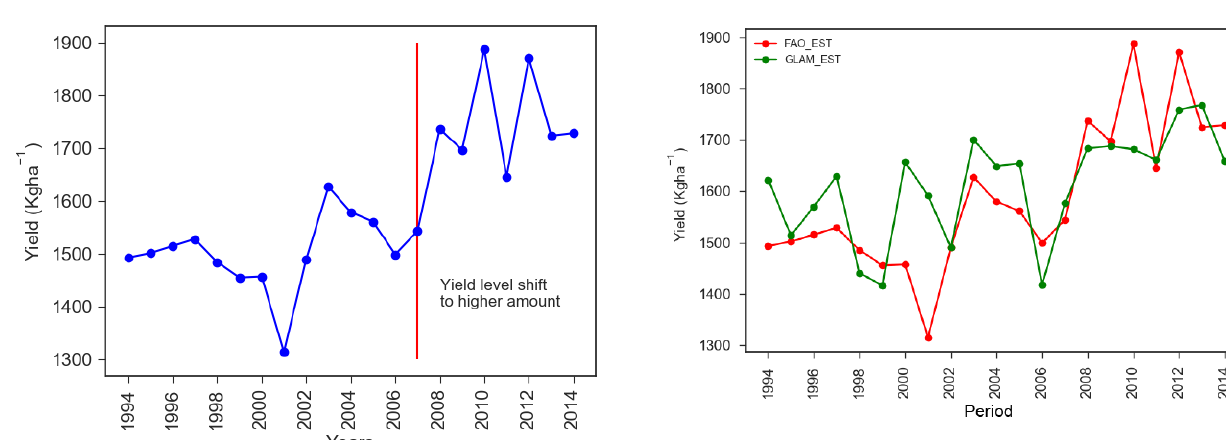
Figure 5. Time series of FAO yield (red line) and GLAM-simulated yield (green